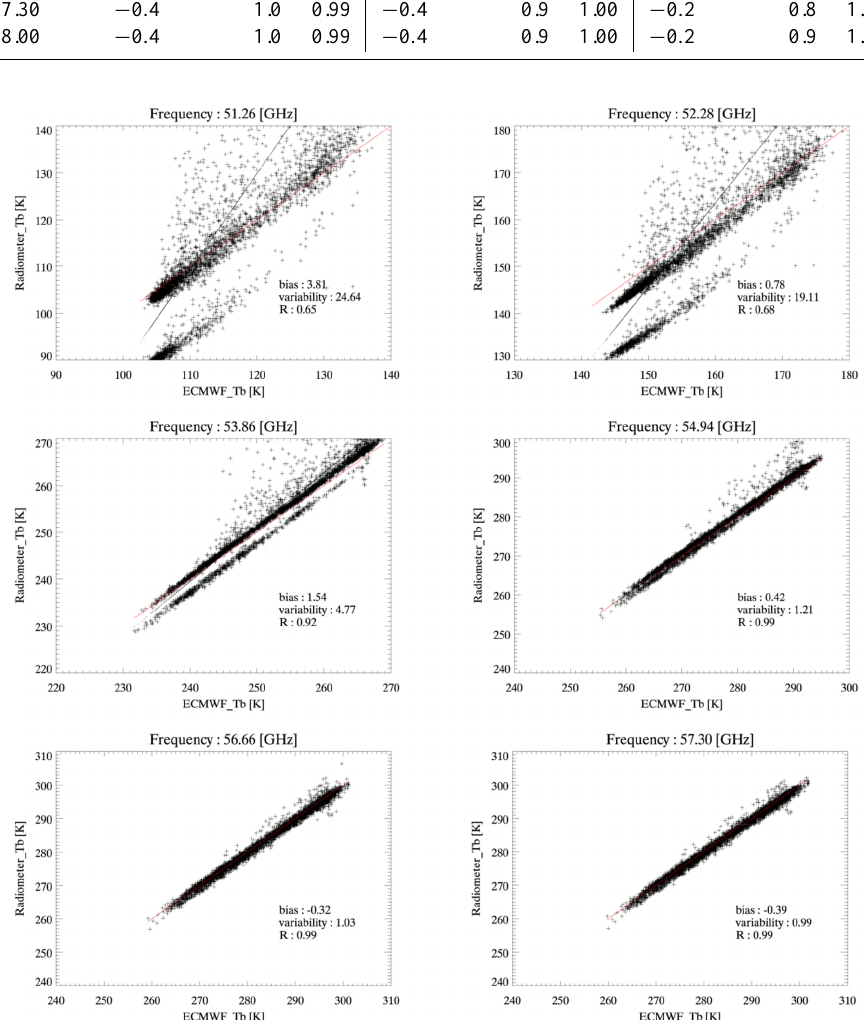
and T E (red line is the one-to-one line and N = 4063). b b